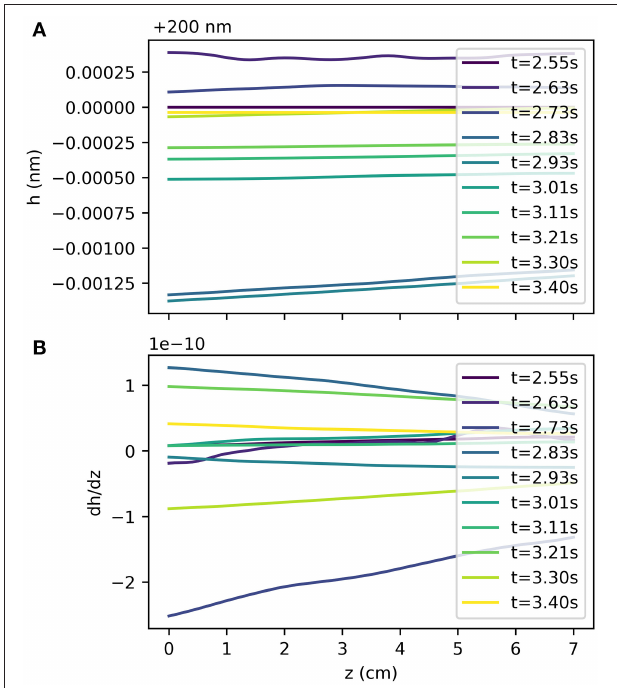
FIGURE 4 | BM width h bm ( z , t ) at several time points during the cardiac cycle (A) and its gradient along the z -axis at the same time points (B) . Pressure pulse driven variations of the BM width are small compared to the initial width of 200m and thus flow through the BM is slow.